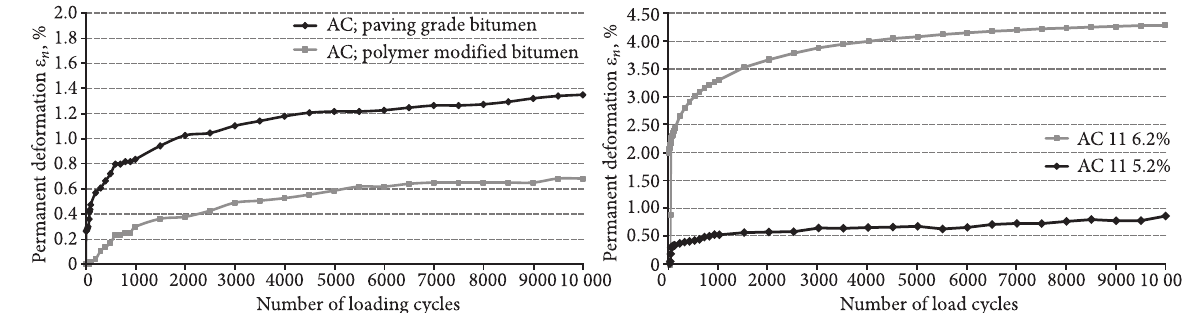
Fig. 5. The creep curve of AC 11 with different binder type – left and different binder content – right (Bežilla et al. 2009; Komačka et al. 2011)